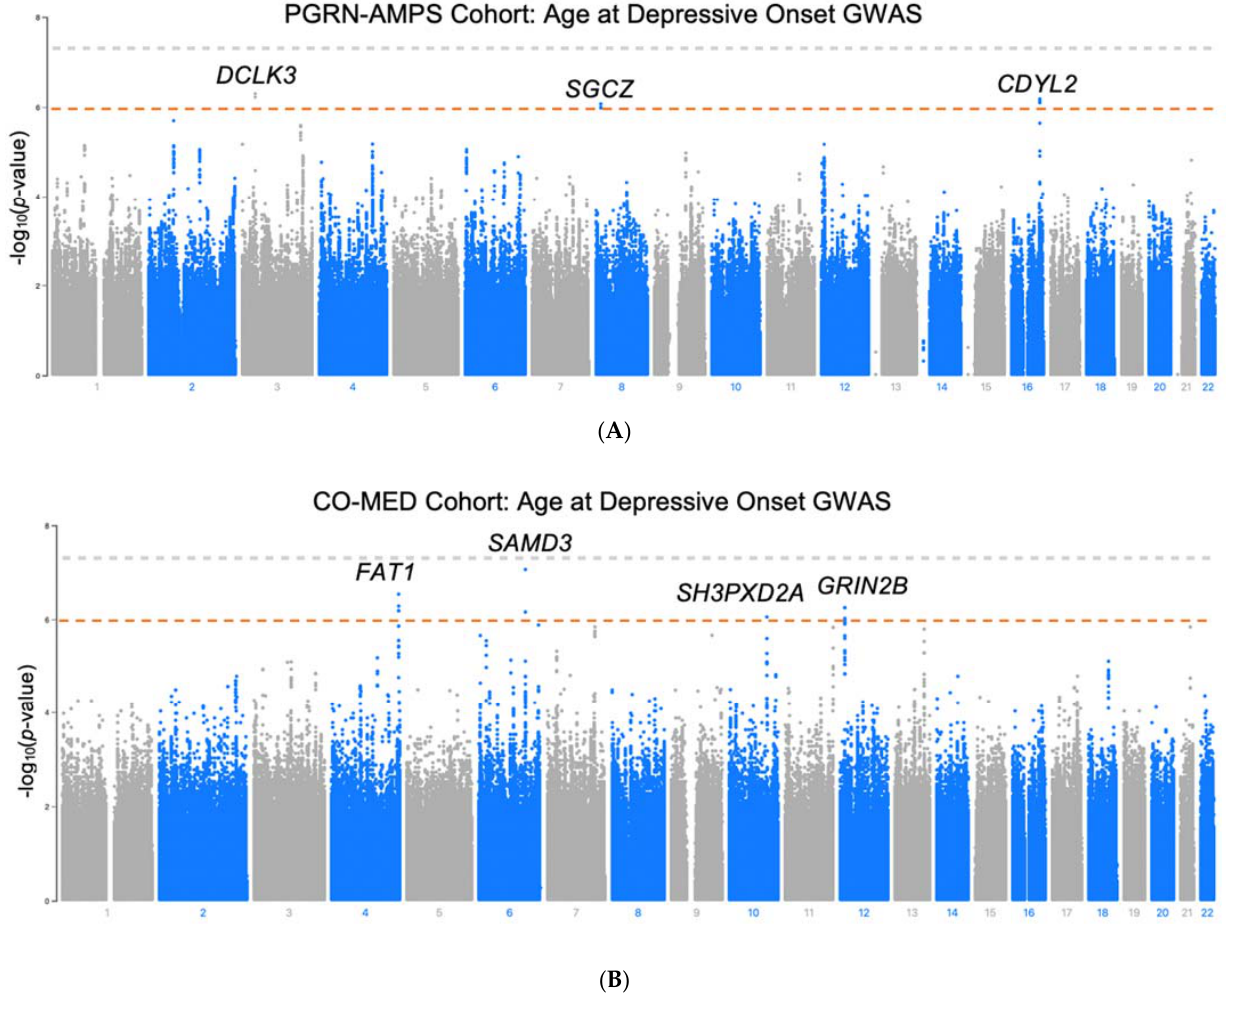
Figure 1. Manhattan plots for GWAS for age at depressive onset in ( A ) PGRN ‐ AMPS cohort ( N = 487) and ( B ) CO ‐ MED ( N = 295). Grey line: genome ‐ wide significance (5 × 10 − 8 ). Red line: suggestive significance (1 × 10 − 6 ). Table 2. Index variants by study.